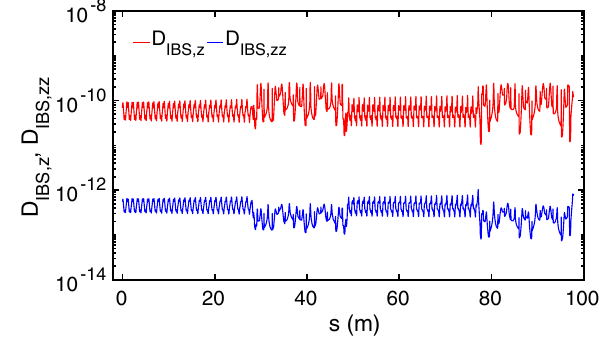
FIG. 6. The calculated IBS friction and diffusion coefficients [see also Eqs.